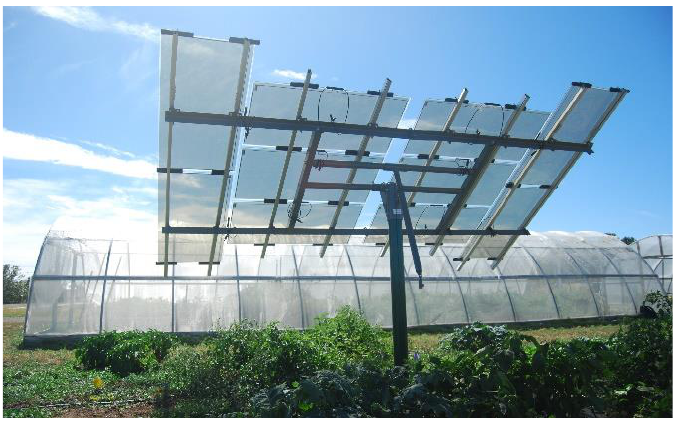
Figure 1. Experimental APV system with semi-transparent CdTe panels. Panels have 40% transpar- ency.